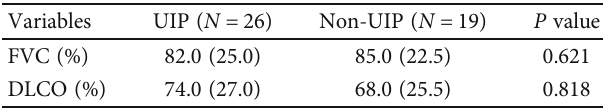
Table 4: Comparison of pulmonary function tests according to ILD patterns ( N = 45